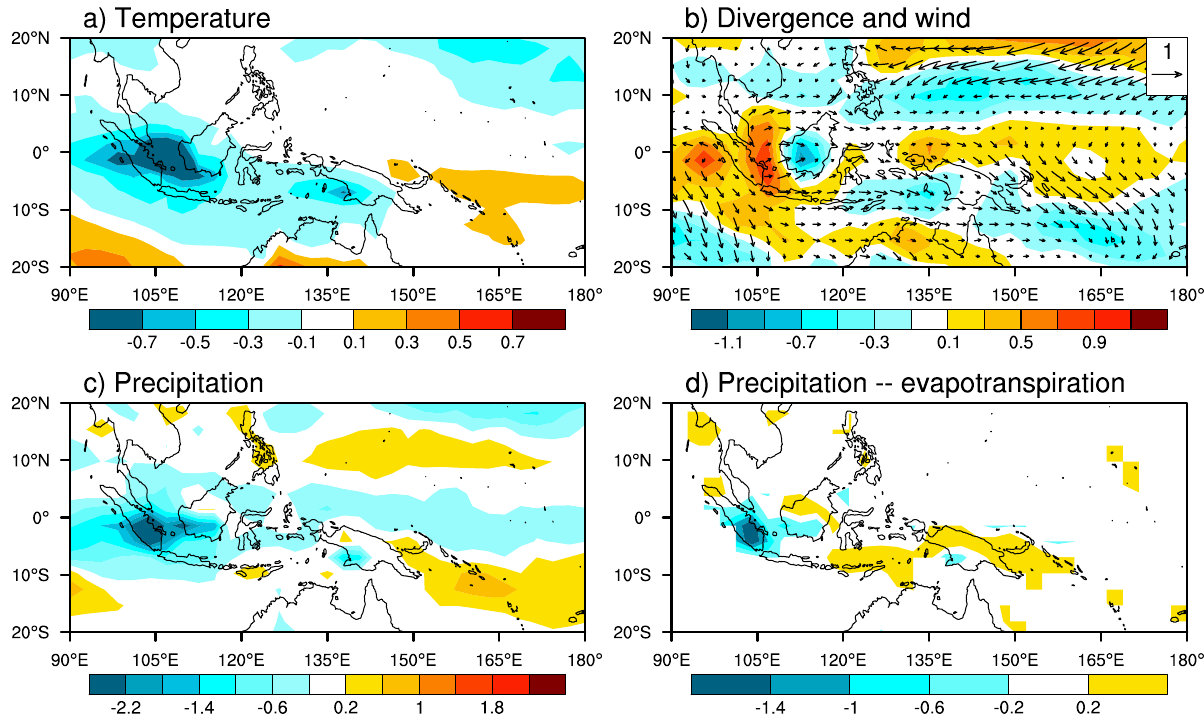
Fig. 5. (a) August–October simulated surface temperature anomalies ( ◦ C), (b) surface divergence (s − 1 ), wind speed (ms − 1 ) and wind direction anomalies, (c) modeled precipitation (mmd − 1 ) anomalies, and (d) precipitation minus evapotranspiration anomalies (mmd − 1 ). All plots are the mean difference between the high and low fire simulations averaged during August–October. Positive surface divergence anomalies (b) are indicated by red and yellow shading, and are associated with decreased